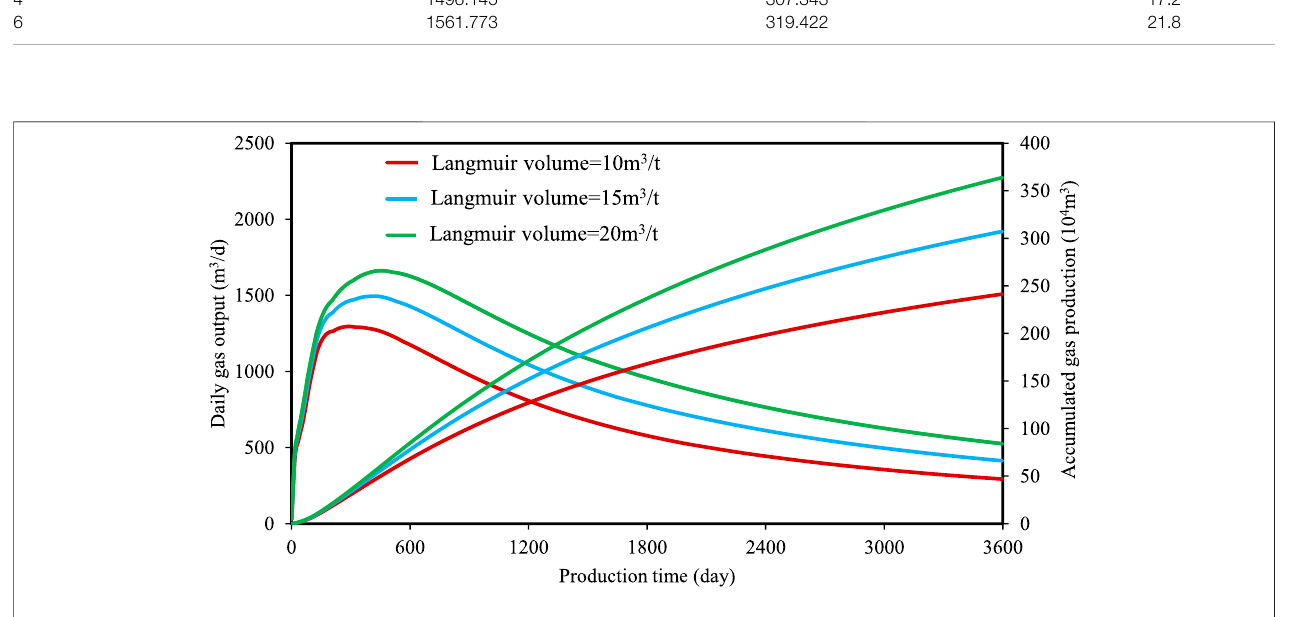
FIGURE 9 | In fl uence of Langmuir volume on CBM production.